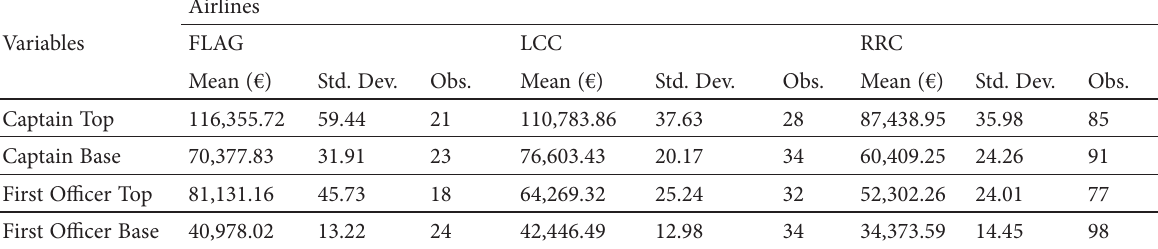
Table 1. Mean and standard deviation. Pilot average wage in 2008